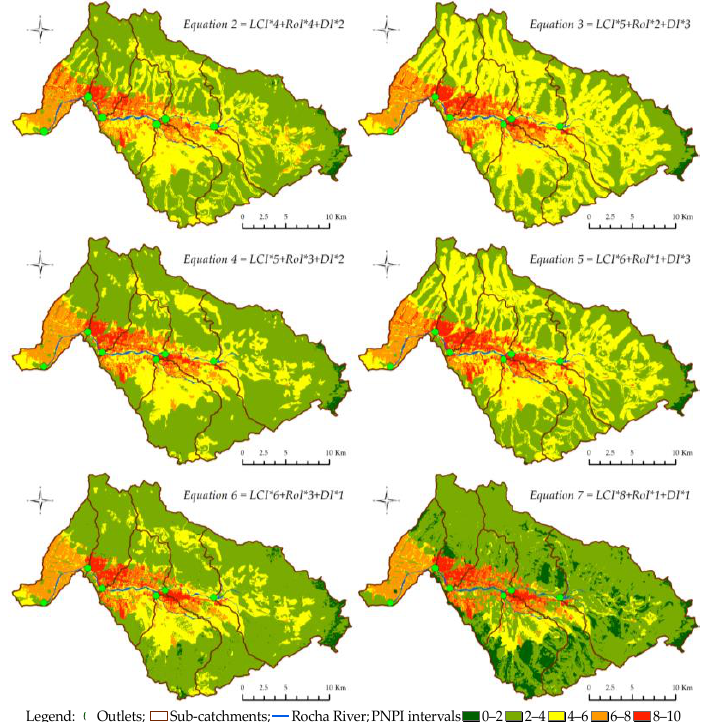
Figure 13. Spatial distribution of potential non-point pollution index (PNPI) classes in the Rocha River catchment in 2017, calculated from Equations (2)–(7). Areas with higher PNPI values (6–8; 8–10, see Table 4) were mainly concentrated along the middle section in the valley lowlands, around the Rocha River main channel (Figures 12 and 13). These areas have higher potential for generation of non-point pollu- tion due to human settlements (Figure 4) with higher population densities (>120 persons per ha) and higher LCI values (Figure 7), higher pollutant mobility due to higher RoI val- ues (Figure 9) and higher DI values (shorter distances to river network; <520 m) (Figure 11). Human settlements in Sacaba and Cochabamba cities, which have increased from 1997 to 2017, were located in these areas. Areas with lower pollution potential (PNPI clas- ses 0–2, 2–4) surrounded the central part towards the edges of the catchment (but not the western part). They corresponded to lower potential generation of non-point pollution due to semi-natural related land use types (forest, shrubland, grassland and mountain lakes) and thus lower LCI values, and low pollutant mobility due to lower RoI and DI (distances to river network >1704 m). The area occupied by the different PNPI classes shown in Figures 12 and 13 is pre- sented in Table 6. In general, increases between 1997 and 2017 in areas covered by higher PNPI classes occurred in increasing order from sub-catchments 1 to 6, while decreases in